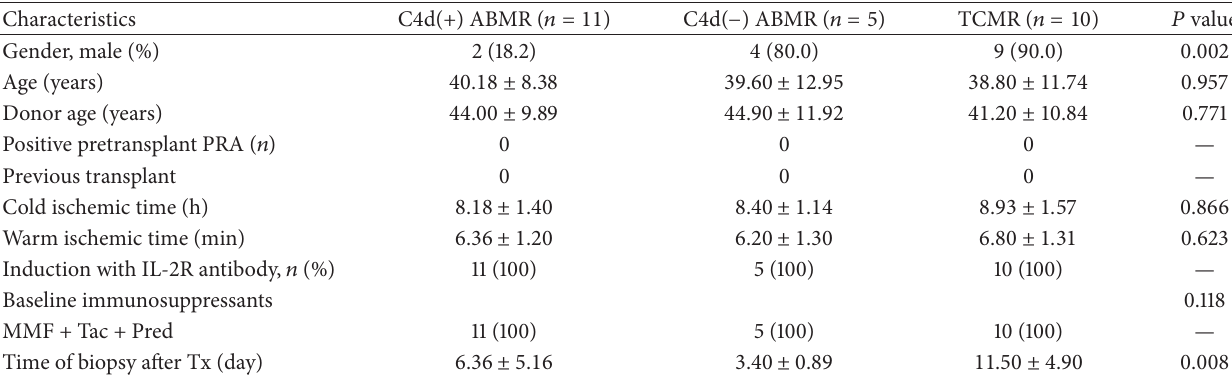
Table 1: Clinical characteristics of patients participating in this